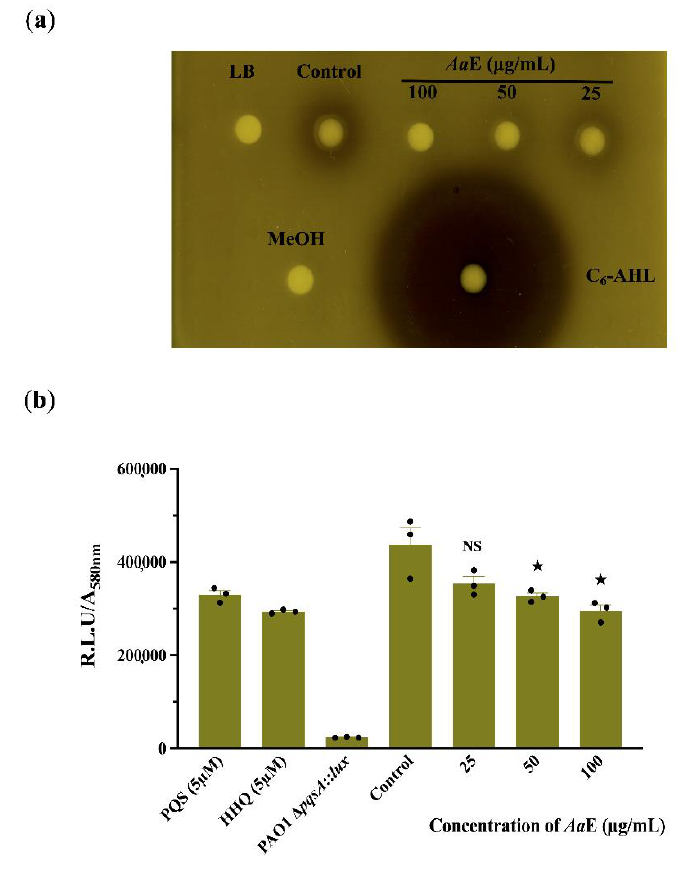
Figure 3. Effect of Aa E on QS-molecule production. ( a ) Crude N -acyl homoserine lactones (AHLs) extracted from H103 cultures untreated (control) or treated with Aa E at 25, 50 and 100 µg/mL were visualized using C. violaceum CV026 biosensor agar plate assay. MeOH, methanol (negative control). LB, AHLs crude ethyl acetate extract from LB medium (negative control). C 6 -HSL, synthetic AHL (positive control). ( b ) Normalized mean maximal bioluminescence output from the 4-hydroxy-2-alkylquinoline (HAQ)-biosensor strain in the presence of crude ethyl acetate HAQs extracts prepared from cultures of H103 treated with different concentrations of Aa E compared to positive control conditions (HHQ and PQS at 5 µM) and to negative control conditions (HAQs crude ethyl acetate extract from HAQ-biosenor strain). Data represent mean ± SEM of at least three independent biological assays. Significant differences between mean values versus control were assessed via GraphPad Prism 8 t- test calculator. ★ , p = 0.01–0.05; NS: (not significant), p > 0.05.